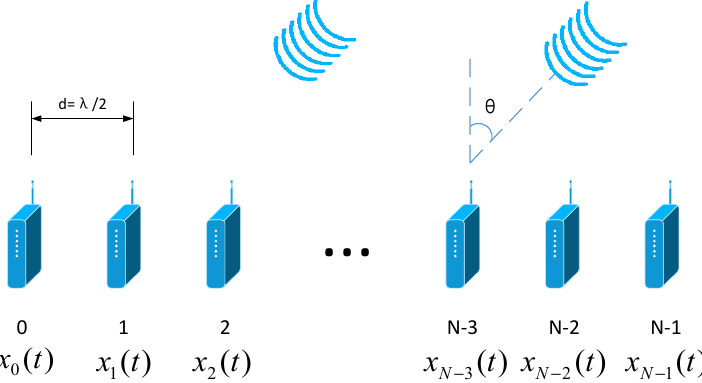
Figure 1. Uniform liner array radar transmit signal model.